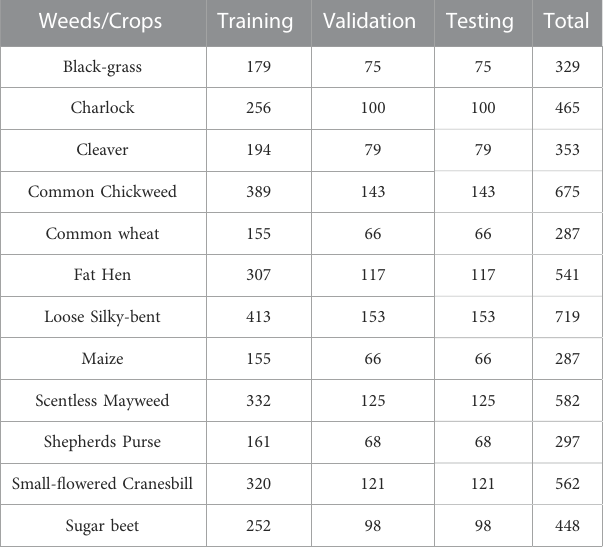
TABLE 1 The total number of training, validation, and testing images of crop and weed species for building the proposed model.